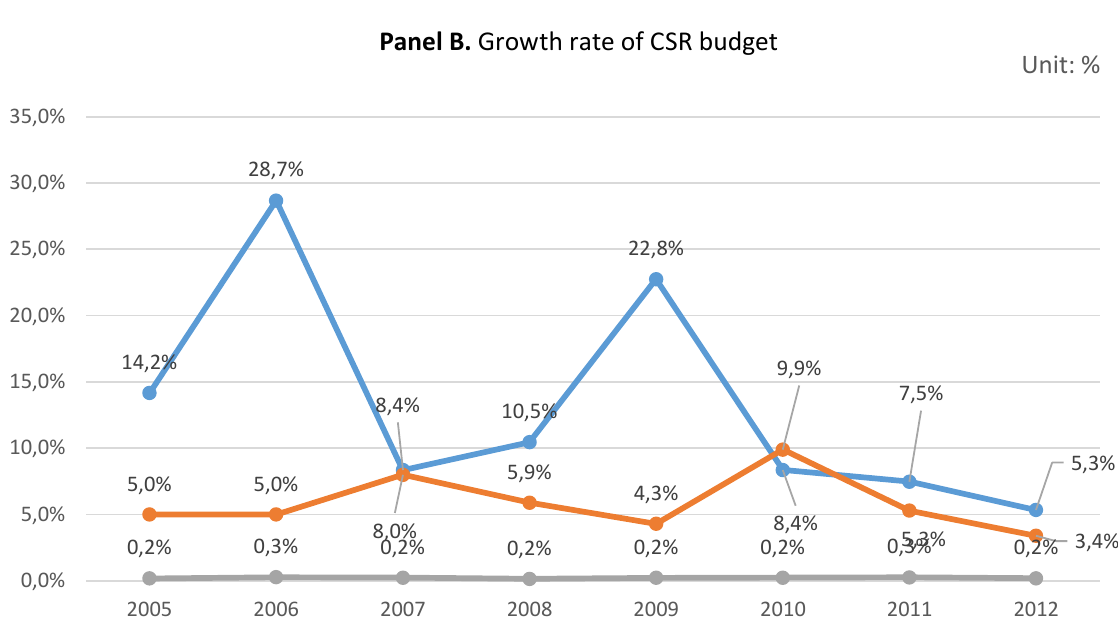
Figure 1. CSR budget trend of Korean